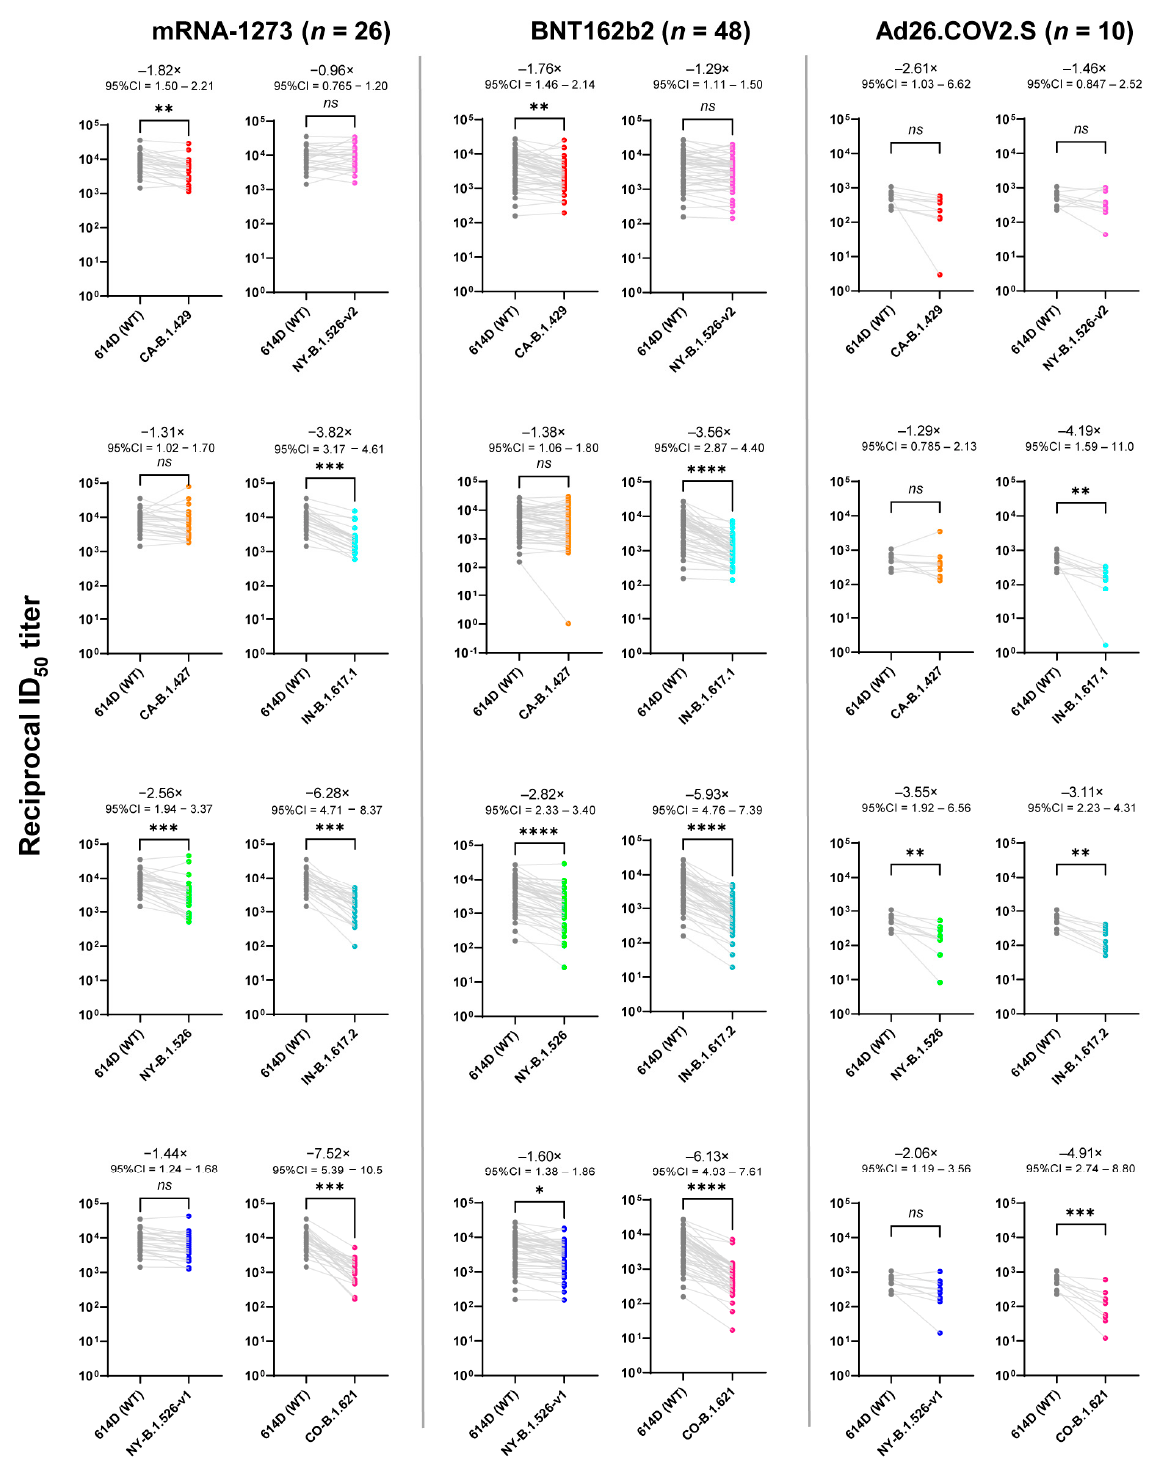
Figure 3. Neutralizing ID 50 values for WT vs. variants in all three vaccine groups. Plasma obtained from mRNA-1273-, BNT162b2- or Ad26.COV2.S-vaccinated subjects were collected. Neutralization